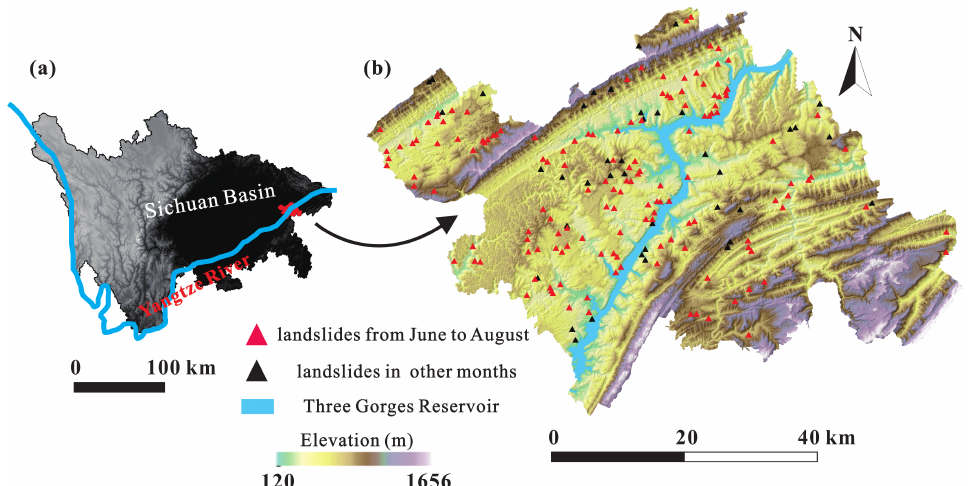
Figure 1. Location of Wanzhou County within the Sichuan Basin, and along Yangtze River ( a ); a topographic map of Wanzhou County highlighting the spatial distribution of shallow landslides in the summer season with red indicators and other months of the year with black indicators ( b ).